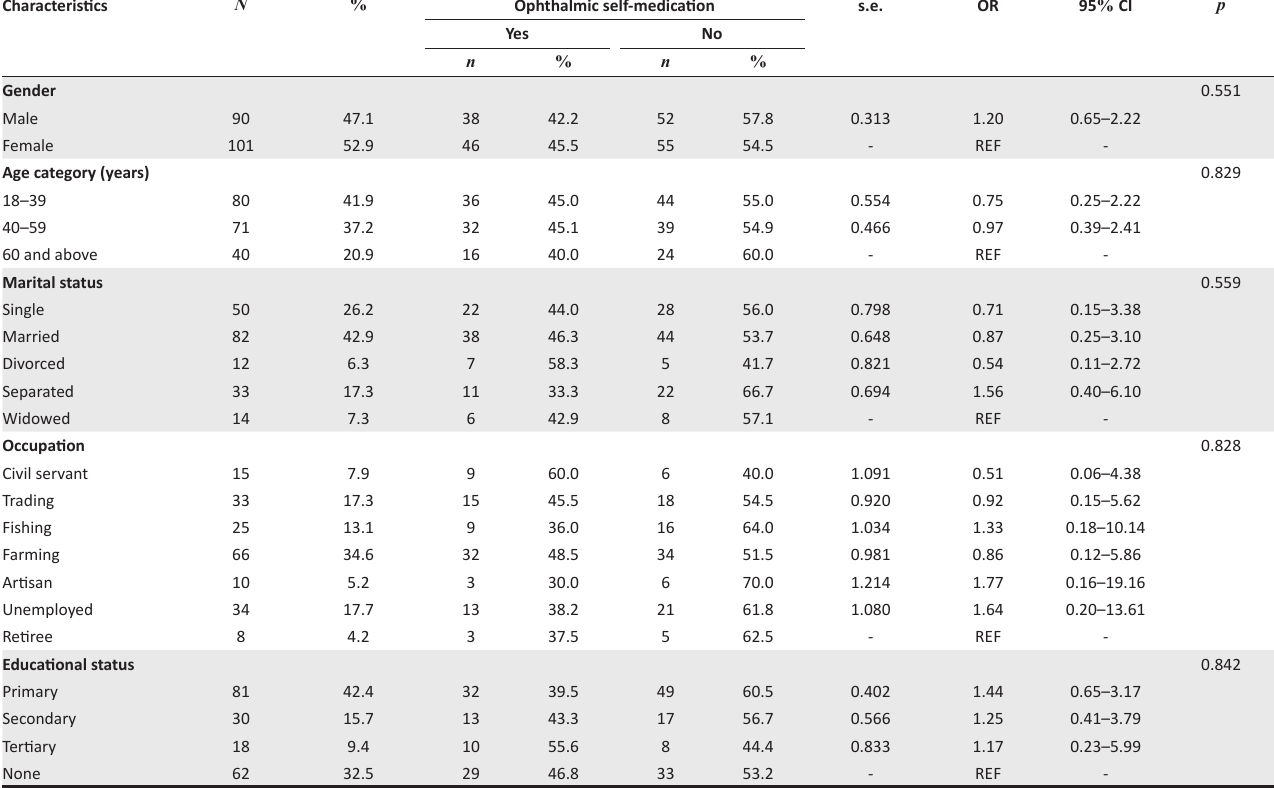
TABLE 3: Ophthalmic self-medication by demographic characteristics of the participants.